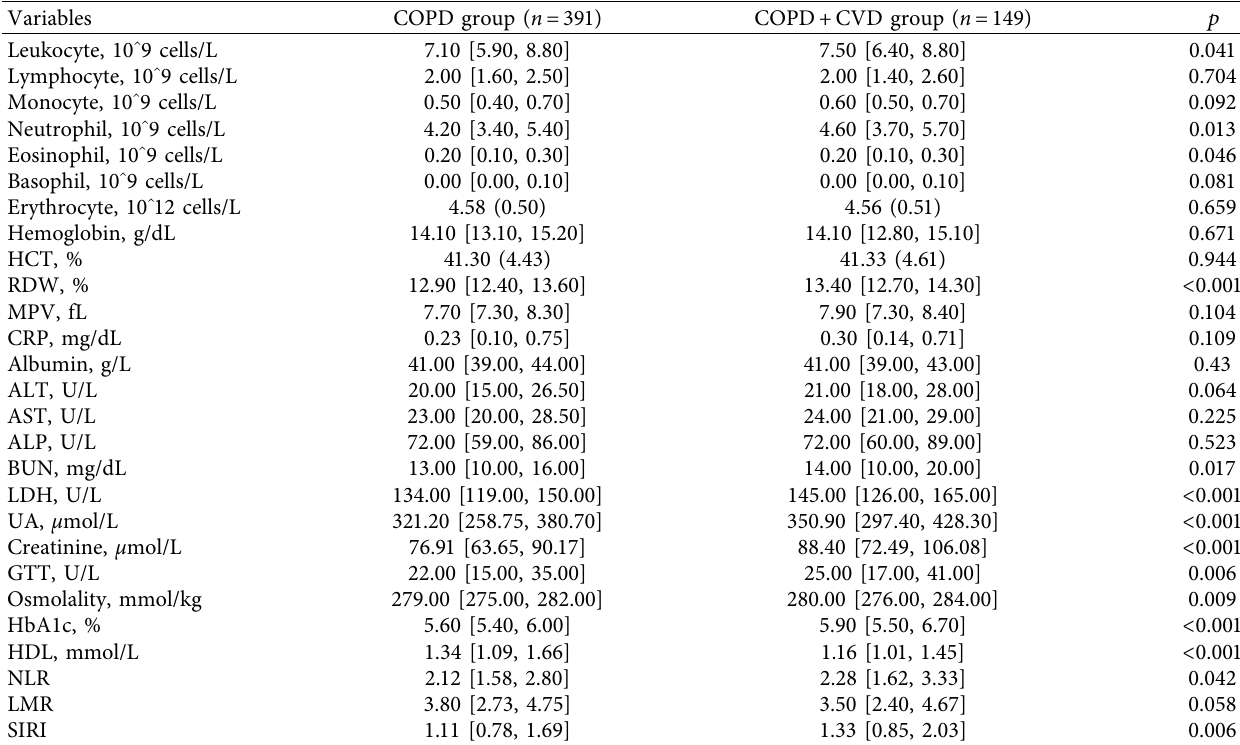
Table 2: Baseline hematological indexes of the included